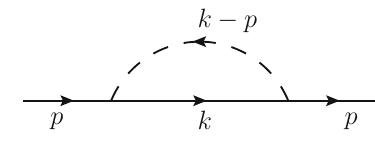
Fig. 5 The fermion self-energy